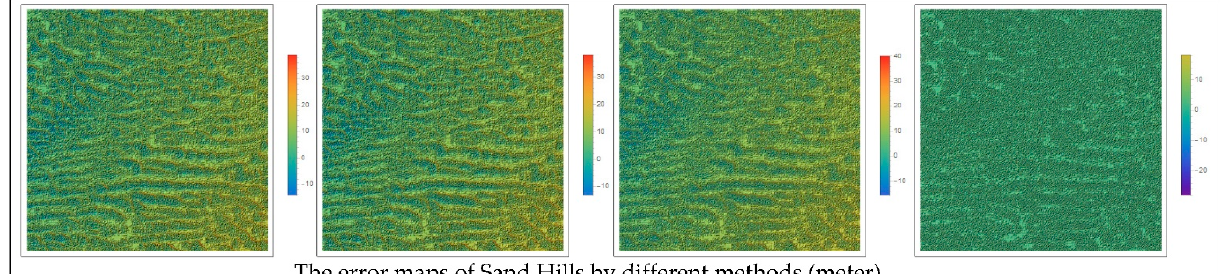
Figure 13. The error maps of the generated SRDEMs with different methods.